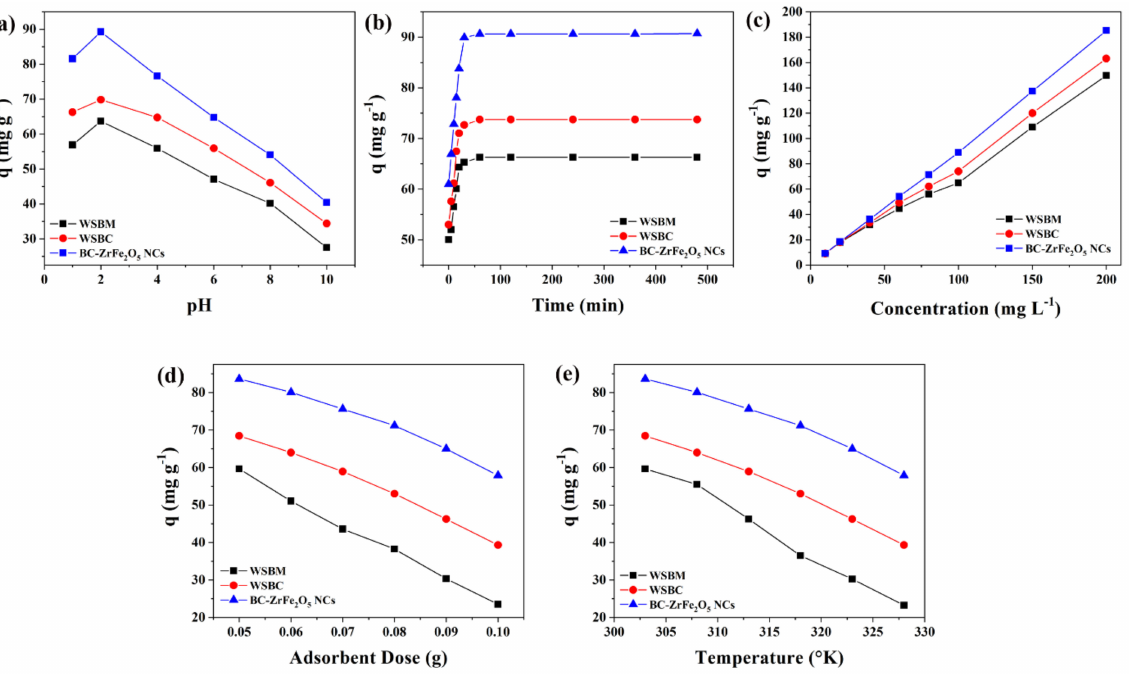
Figure 5. Influence of ( a ) pH, ( b ) time of contact, ( c ) initial concentration, ( d ) sorbent dosage, ( e ) temperature on the adsorption of Tartrazine dye using, WSBM, WSBC and BC-ZrFe 2 O 5